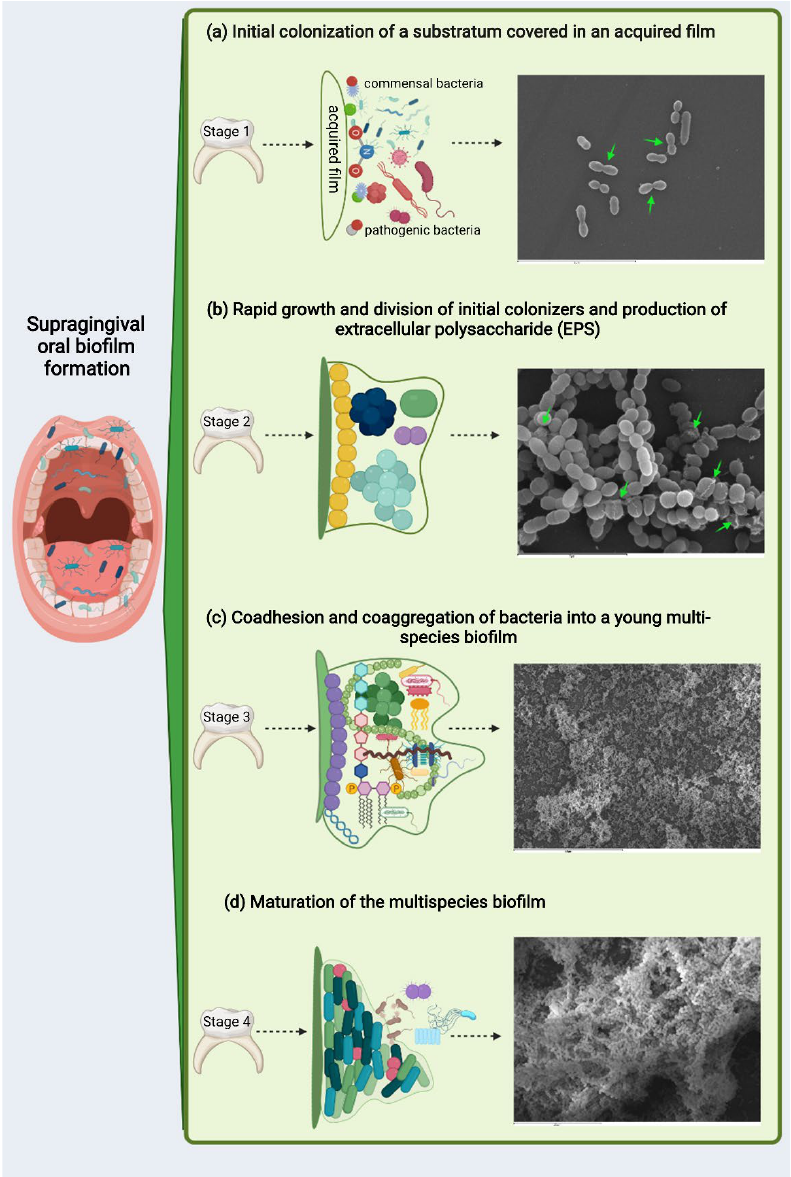
Figure 1. Illustration exemplifying the possible development of multispecies biofilms. Scanning electron microscopy corresponds to an in vitro supragingival biofilm model of ( a ) 3, ( b ) 12, ( c ) 24, and ( d ) 48 h of evolution (to methodology [9] ): ( a ) initial colonization of a substratum covered in an acquired film composed of polysaccharides and proteins. In vitro, various bacteria of coccoid and bacillary morphology can be seen on the surface after 3 h of biofilm process initiation; cell division can be appreciated mainly in coccoid bacteria (green arrows; scale bar = 9 µm); ( b ) rapid growth and division of initial colonizers and production of extracellular polysaccharide (EPS) leading to the development of microcolonies from several bacterial species—green arrows point to EPS surrounding bacteria in a microcolony after 12 h of biofilm development in vitro, which is identifiable in the image as a compact mass of greater brightness—(scale bar = 5 µ m); ( c ) coadhesion and coaggregation of bacteria into a young multispecies biofilm—after 24 h of in vitro evolution, the surface appeared to be covered by bacteria consisting primarily of a larger colonies—outward-growing masses of bacterial cells alternating with flat homogenous layers of cells (scale bar = 50 µ m); and ( d ) maturation of the multispecies biofilm—after 48 h of in vitro incubation, biofilm demonstrated the characteristic organization of these communities: covering the surface with bacteria clusters, forming stacks, and showing channels inside the structure—(scale bar = 20 µ